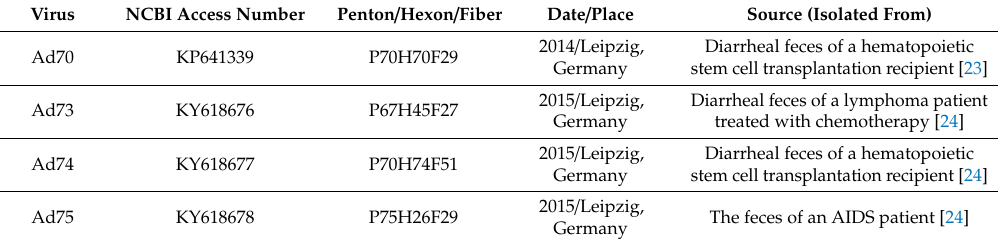
Table 1. Summary of New Species D Human Adenoviruses used in this